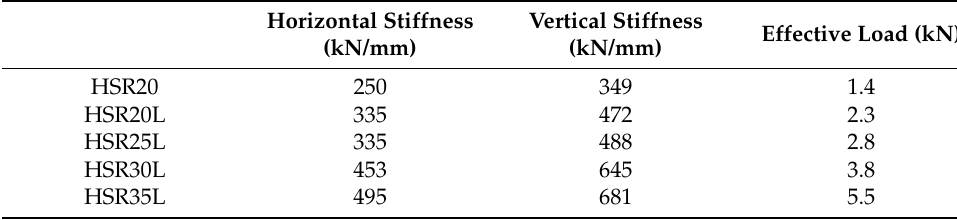
Figure 3. LM Guide ( a ) components and ( b ) stiffness elements. Table 1. Stiffness of HSR LM Guides.